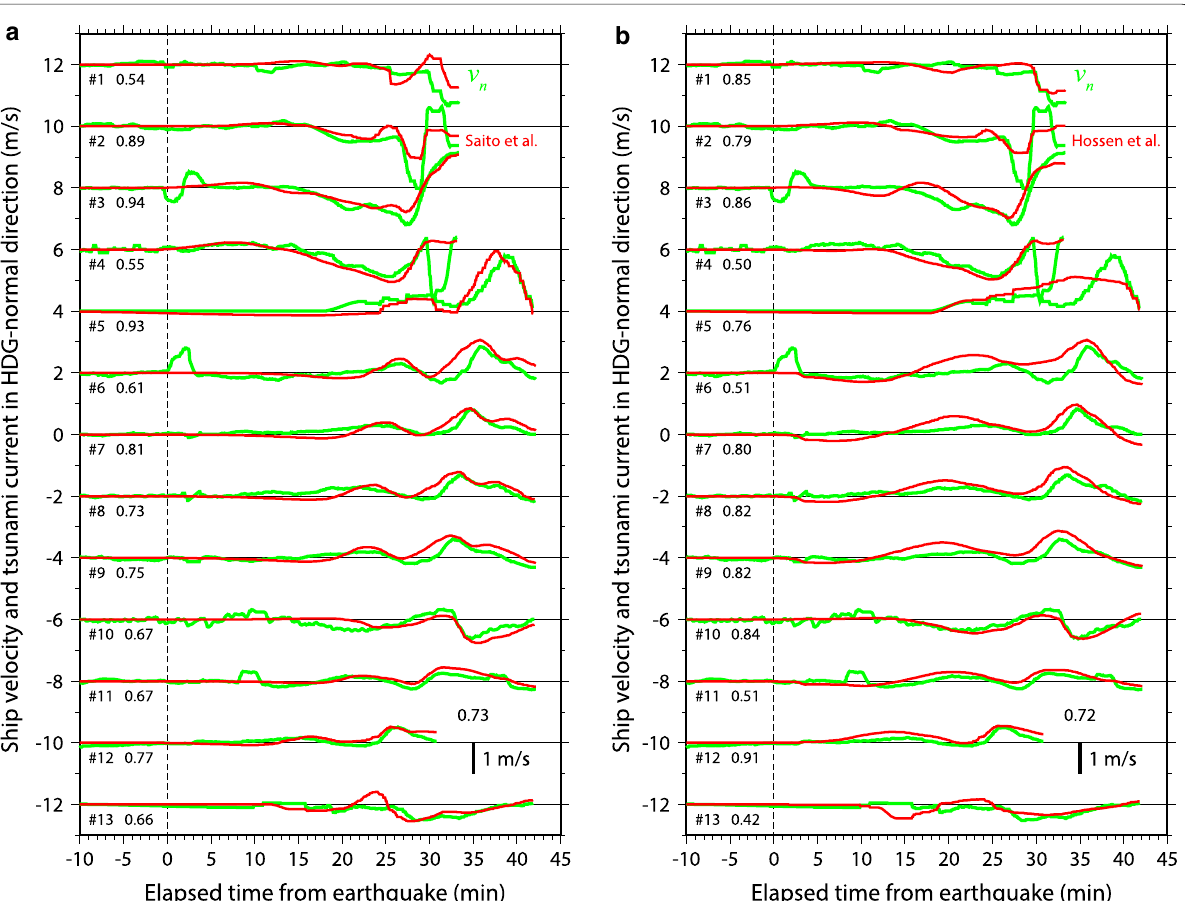
Fig. 3 Ship velocity (green) and simulated tsunami current (red) in the HDG-normal direction for the 13 ships. The simulations are carried out using the initial conditions of a Saito et al. (2011) and b Hossen et al. (2015), respectively. The plots in a is the same as Fig. 5 of Inazu et al. (2018). Correlation coefficients between the ship velocity and the simulations are attached for the respective ships. Mean correlation coefficient is shown at lower right of each